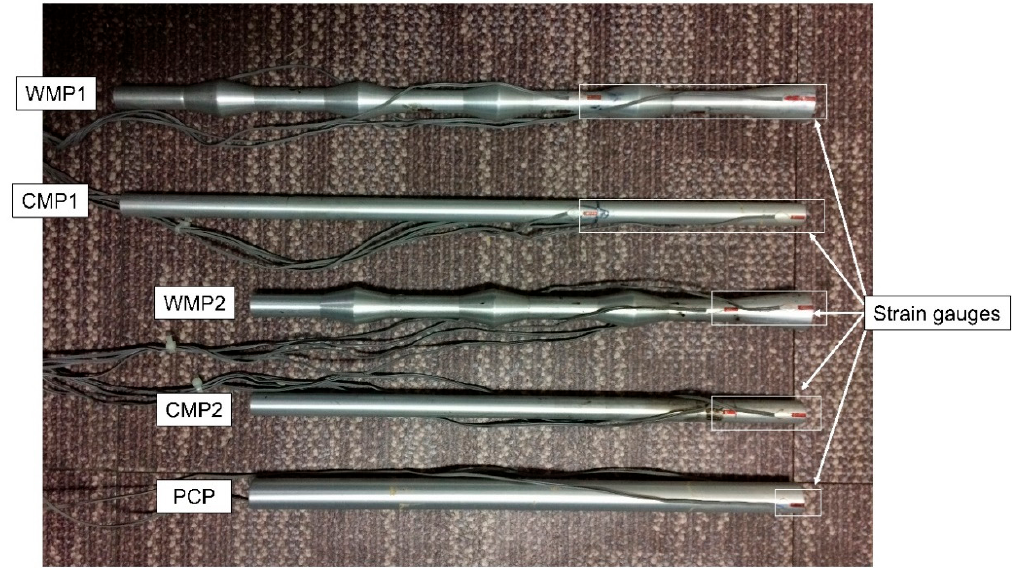
Figure 3. Model piles with attachment of strain gauges. Table 1. Size and properties of prototype and model